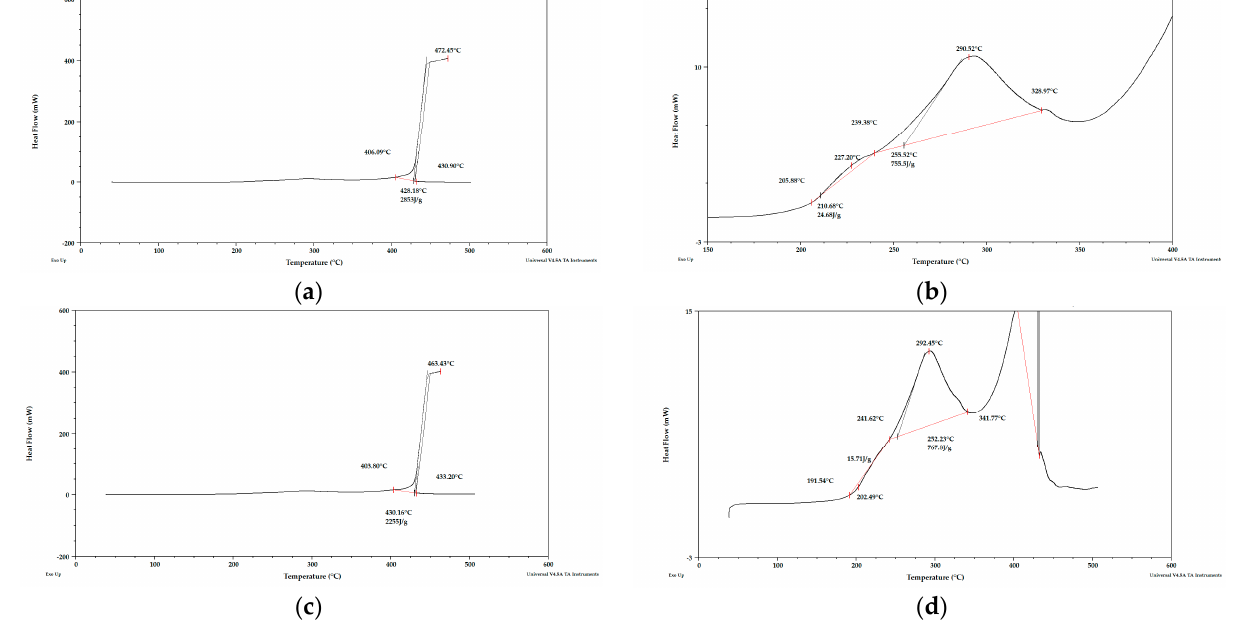
Figure 11. PDSC curves for apple pomace dried to dry weight ( a ) sample 1, ( b ) sample 1 enlarged, ( c ) sample 2, ( d ) sample 2 enlarged. Analysis in an oxygen atmosphere.